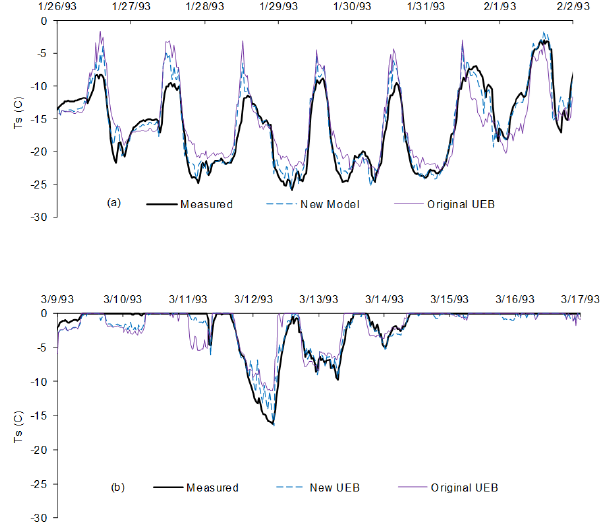
Figure 8. Comparisons of snow surface temperature in 1993 at the USU drainage farm. (a) the first 2 subfreezing weeks, and (b) end of the modeling period when the snowpack is occasionally in an isothermal